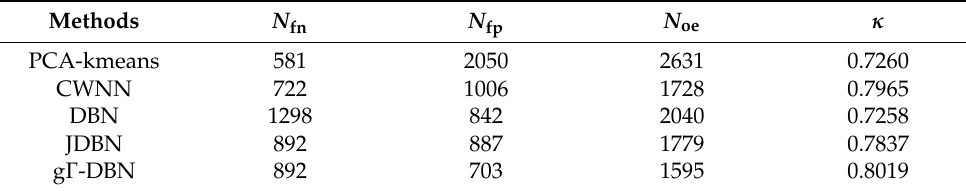
Table 4. Quantitative evaluation of the River data set.